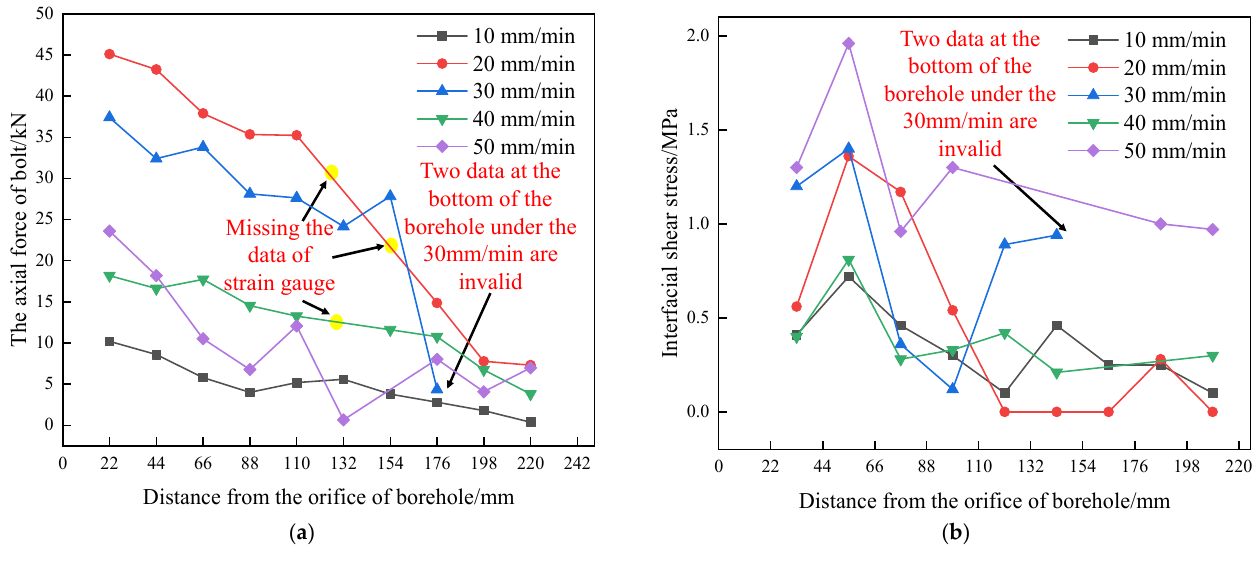
Figure 8. Relationship between maximum drawing force and maximum pull-out load time under different pull-out rates: ( a ) axial force; ( b ) interfacial shear stress.